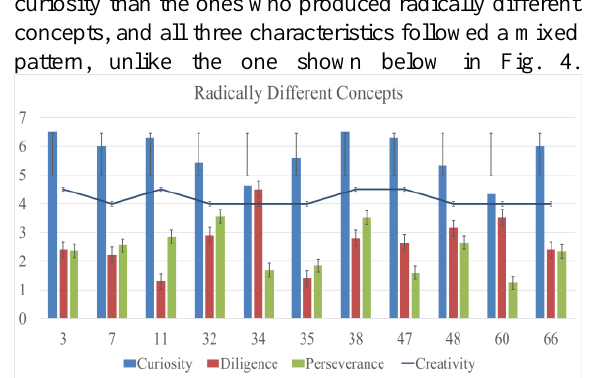
Fig. 4: Radically different concepts